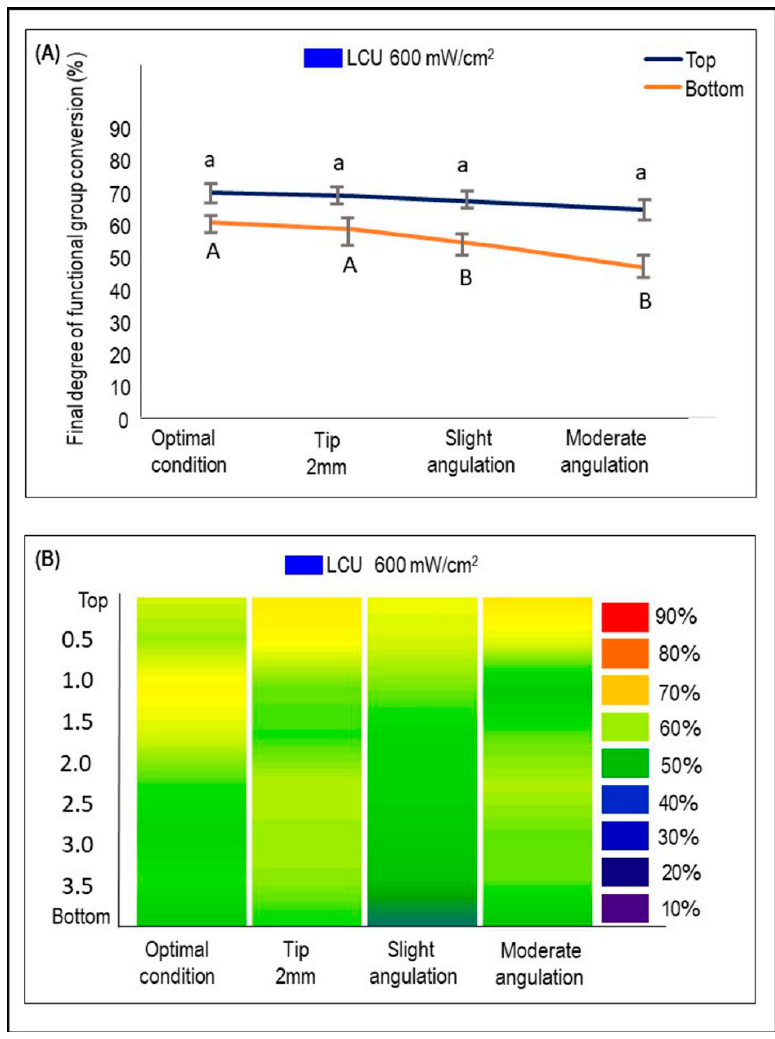
Figure 4. The %DC using LCU 600 with an output of 600 mW/cm 2 at the top and bottom of BF composites cured optimally or following the underperformed conditions (mean ± sd; n = 3). ( A ) The %DC values at the top and bottom of each condition. Lower case letters compare the %DC at the top of the specimen, while capital case letters compare the %DC at the bottom. Dissimilar letters are significantly different from each other ( p < 0.05). ( B ) The %DC is measured at different depths from top to bottom and visualized by the heat maps. The color bar (right) illustrates the visual representation of the %DC corresponding to the colors